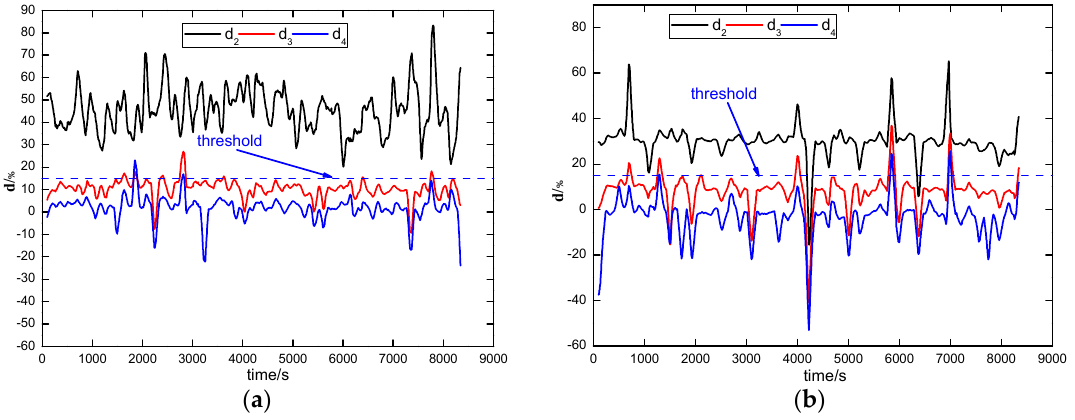
Figure 13. PCBG resistance deviation for PCBGs: ( a ) cell loose contacting fault; ( b ) cell aging inconsistency fault.